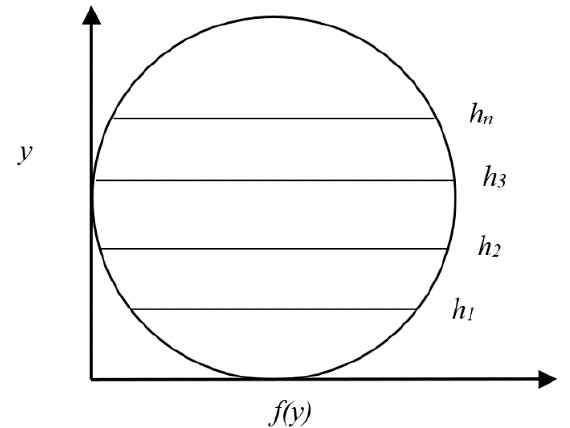
Figure A6. Pipe section with fluid split along y = h.